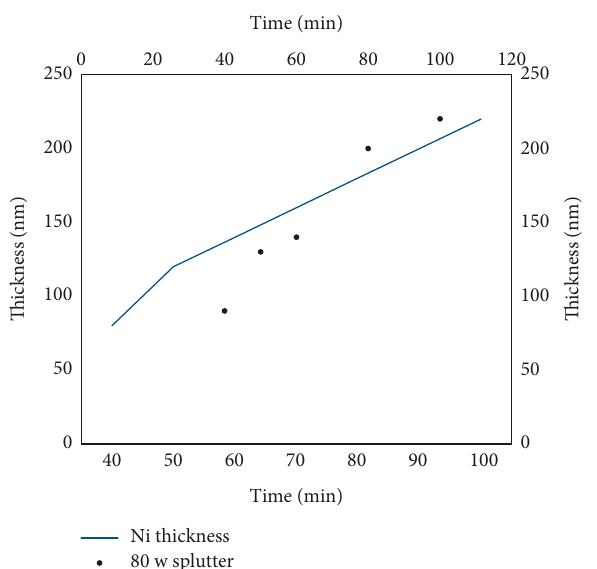
Figure 5: Relationship between Ni thickness and time of 80 w sputtering.